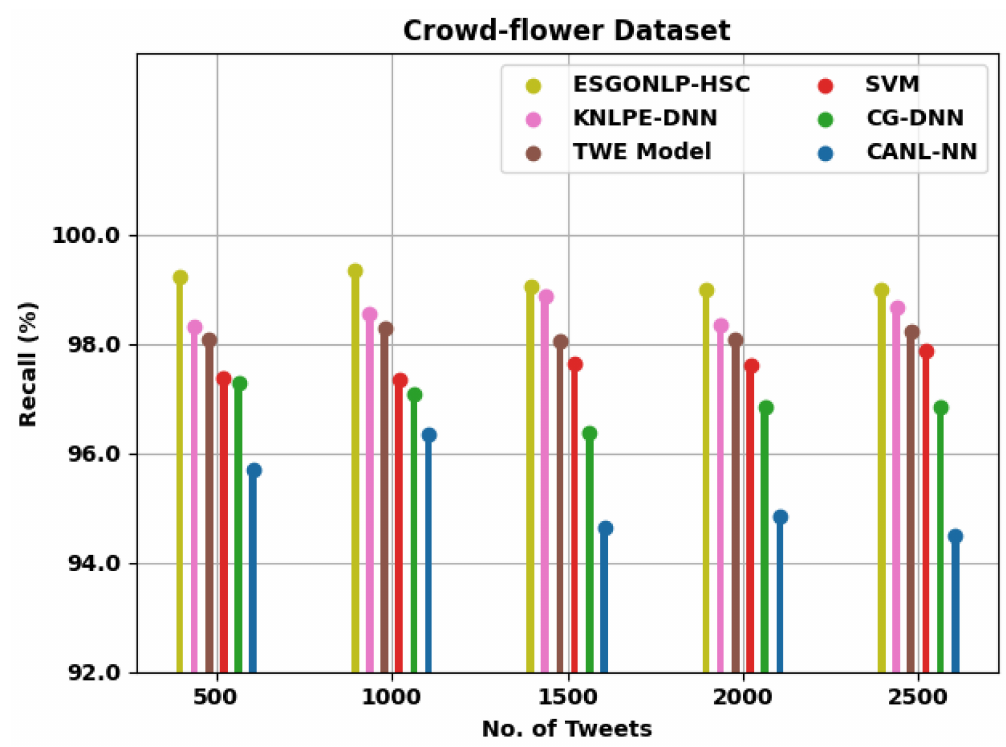
Figure 8. Reca l analysis of ESGONLP-HSC technique under Crowd-flower dataset.